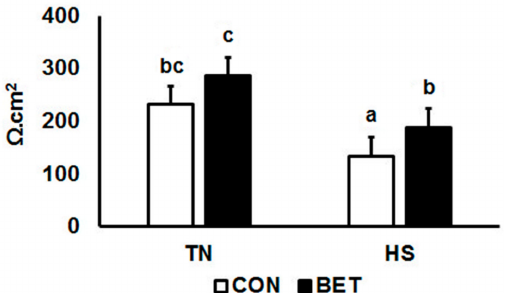
Figure 3. Transepithelial electrical resistance (TER) changes in broilers during a thermoneutral (TN) vs. heat stress (HS) environmental challenge. Broilers were fed either a control diet (CON) or betaine diet (BET), and the mean represents the main e ff ect of 3 time points (3, 7 and 10 day challenge). Refer to Table 2 for full interactive e ff